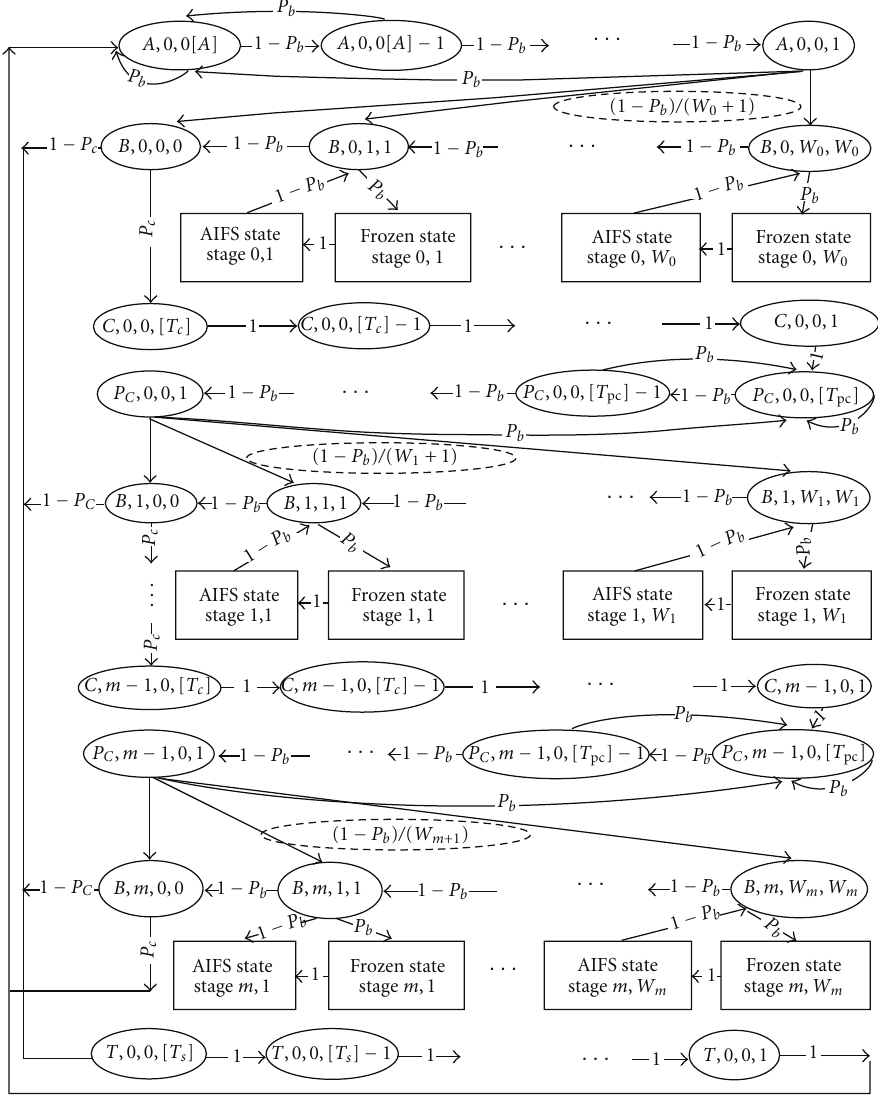
Figure 10: Markov chain of the model.